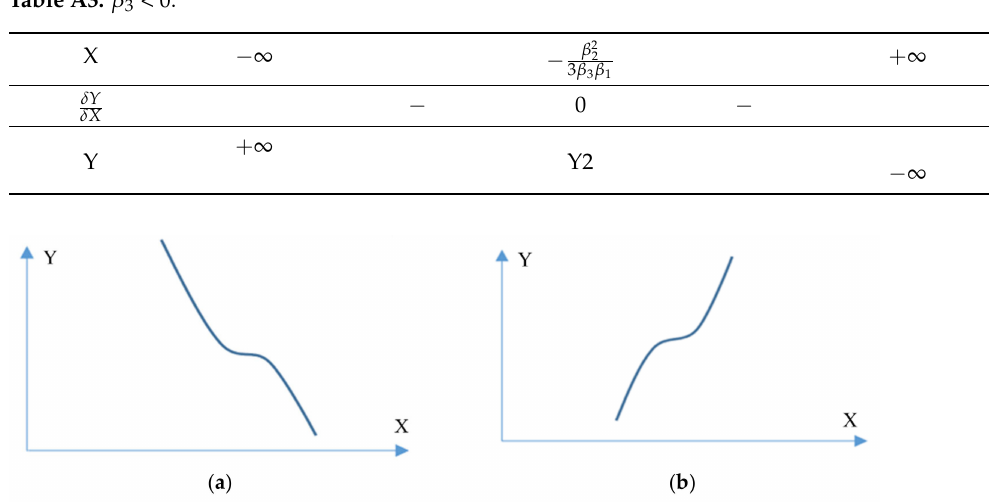
Figure A1. The cubic shape when equation (A1) has one turning point: ( a ) β 3 < 0; ( b ) β 3 >